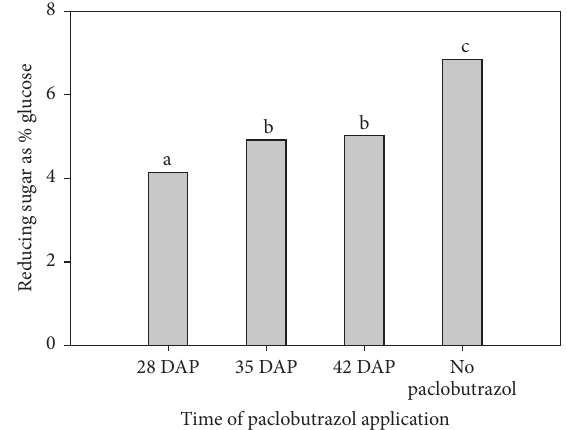
Figure 4: Effect of time of paclobutrazol application on potato tuber reducing sugar content as %